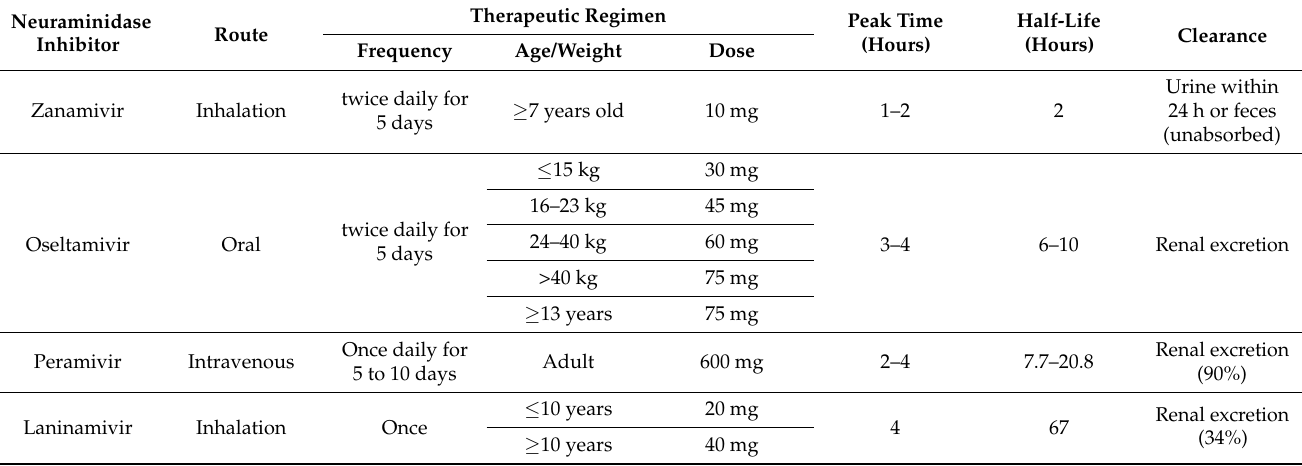
Table 1. Recommended therapeutic regimens for neuraminidase